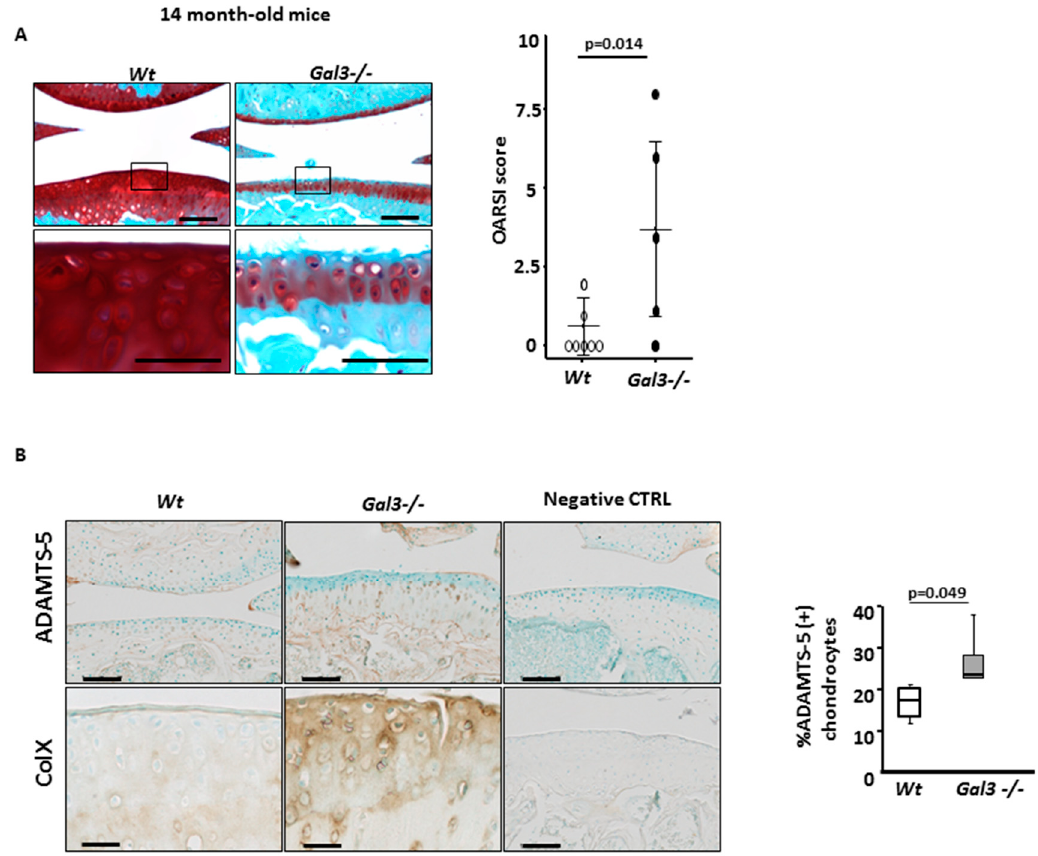
Figure 1. Galectin 3 (GAL3) deficiency induces osteoarthritis (OA) during aging. ( A ) Knee cartilage sections stained with safranin-O from non-operated Gal3 − / − ( n = 5 mice) and wild-type (WT) ( n = 7 mice) 14-month-old mice. Low (top panels) and high (low panels) magnification are presented. OA lesions were assessed by OARSI score (right panel). ( B ) Immunohistochemistry of expression of ADAMTS-5 and type X collagen ( n = 4 WT and n = 7 Gal3 − / − mice). The percentage of ADAMTS-5-positive chondrocytes in Gal3 − / − and WT cartilage was counted (( B ), right panel). Negative controls were nonspecific IgG antibodies. Scale bars: 100 µ m. Two-tailed Mann–Whitney U test between WT and Gal3 − / − .